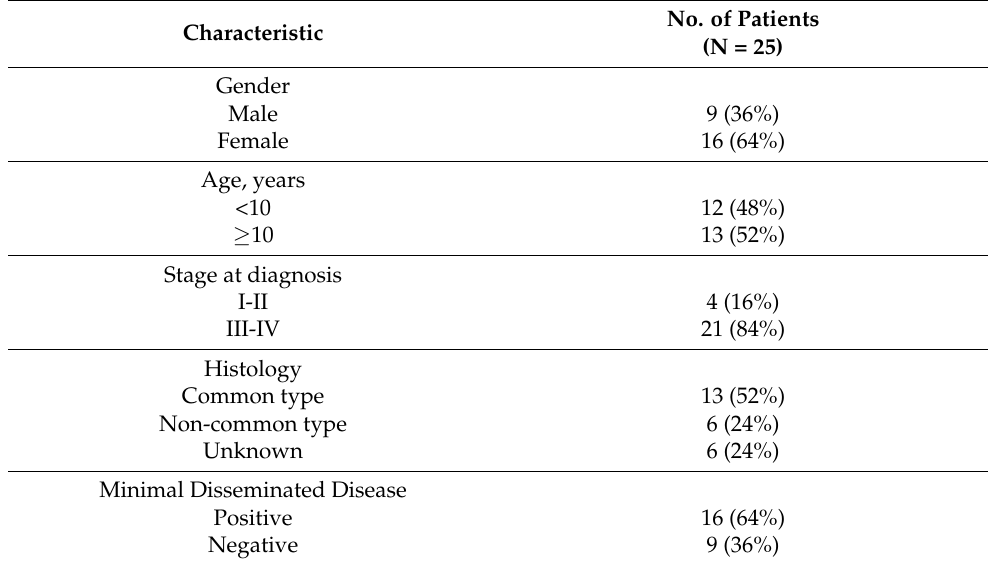
No. of Patients (N = 25)